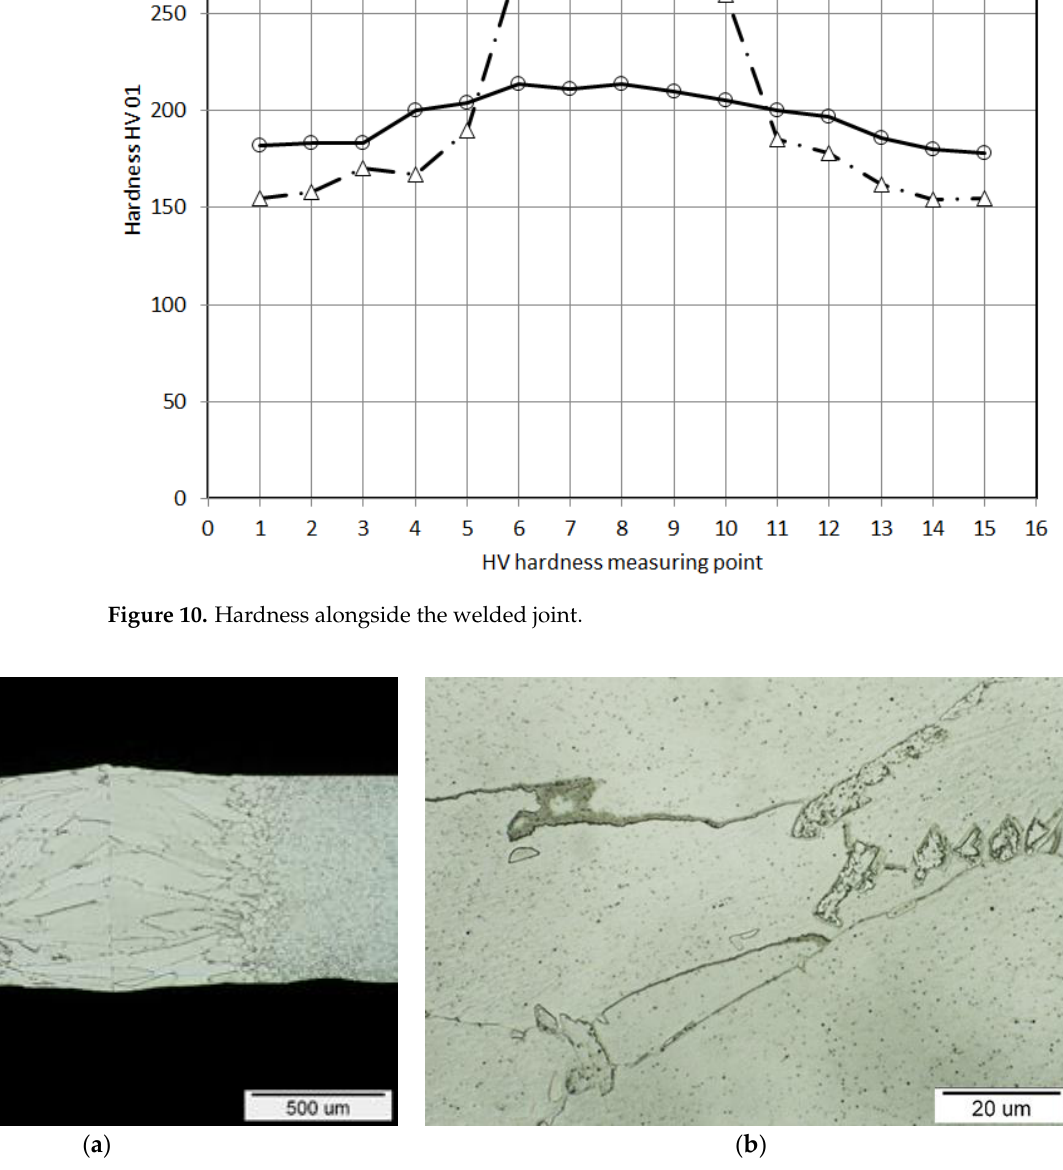
Figure 10. Hardness alongside the welded joint.